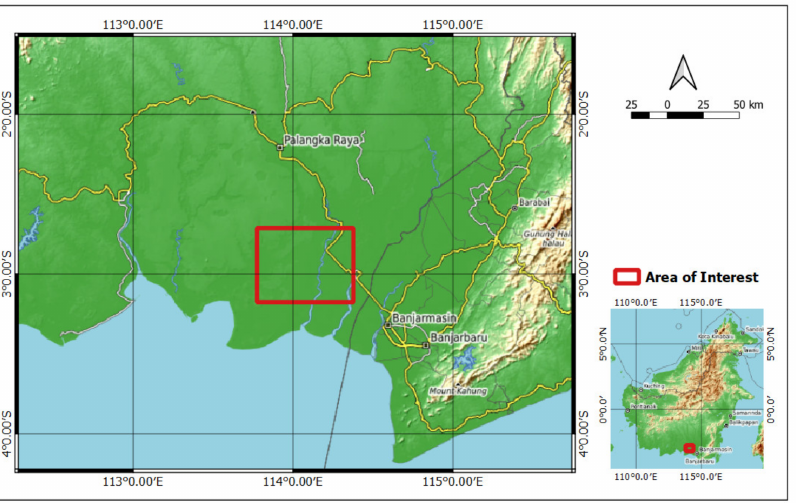
Figure 1. A part of the region of Pulang Pisau Regency and Kapuas Regency, Central Kalimantan, Indonesia as the area of